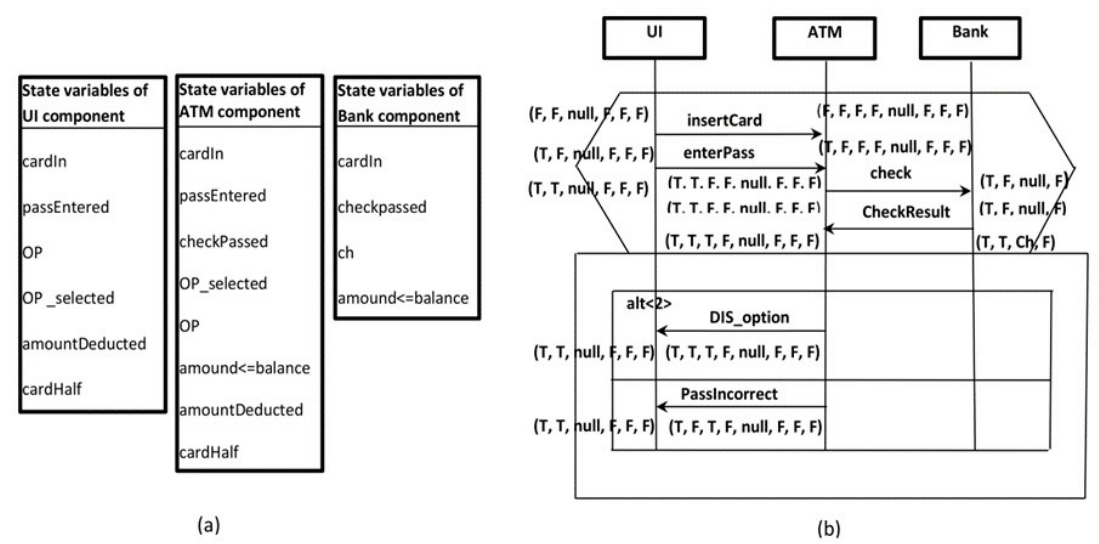
Figure 4. The scenario of password verification after the annotation and propagation. ( a ) State variables of the components participate in the scenario which is the main input for annotation. ( b ) The scenario of password verification that annotated and propagated using the state variables shown in figure ( a ).